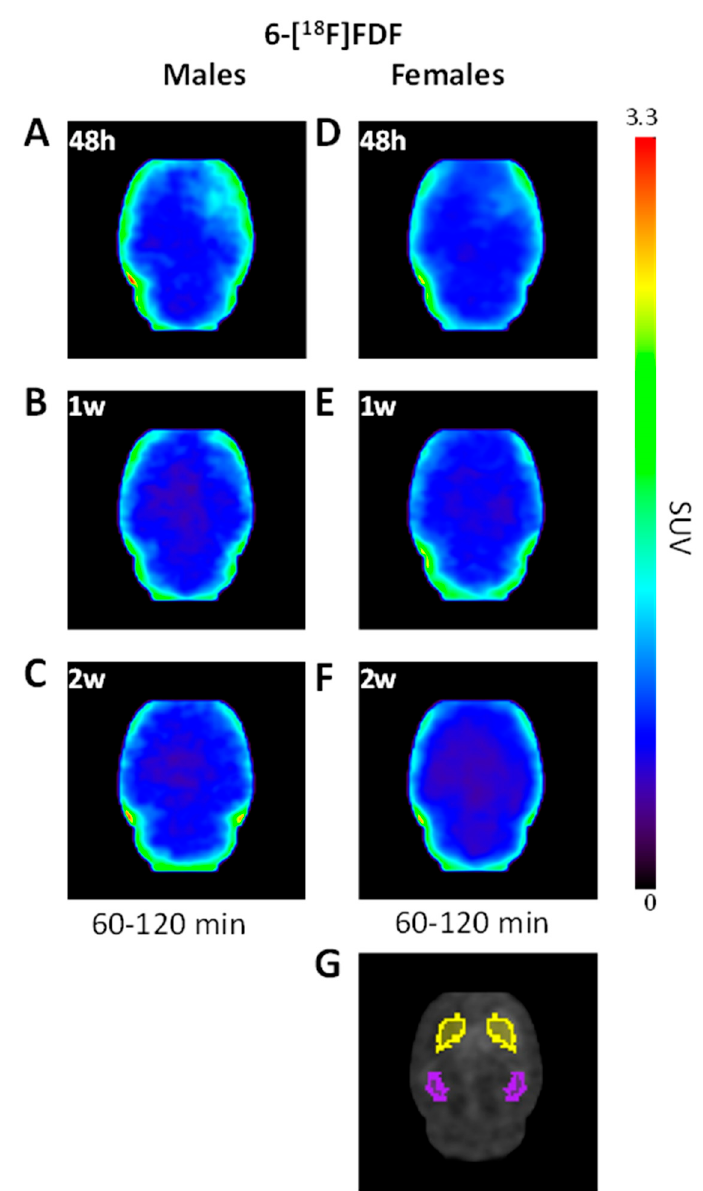
Figure 1. Representative static iterative transverse PET images of 6-[ 18 F]FDF binding in unilateral lipopolysaccharide (LPS)–injected rat striatum in male ( A – C ) and female rats ( D – F ) at 48 h, 1 week, and 2 weeks post–LPS, and ( G ) MRI indicating the regions of interest of striatum (yellow) and hippocampus (purple).